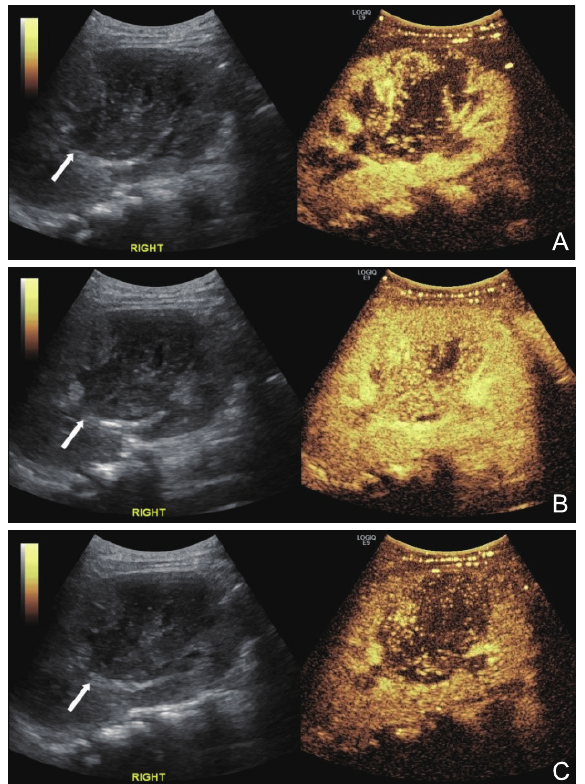
Figure 2 The CEUS of right kidney. (A) The mass showed a rapid diffuse enhancement in the cortical phase. (B) In the corticomedullary phase, the mass showed a low enhancement compared with the renal parenchyma around, and washed out rapidly. (C) In the late phase, the agent signal in the mass almost cleared out while that in the renal parenchyma still existed.